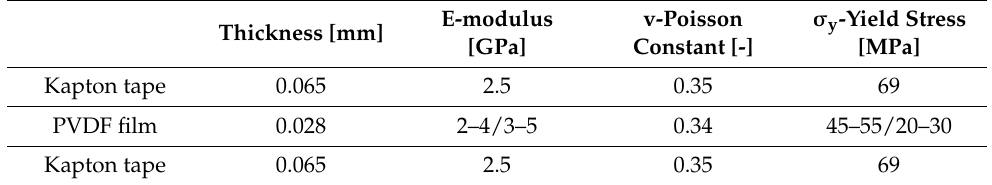
Table 1. The considered mechanical properties for the analytical and numerical solution.